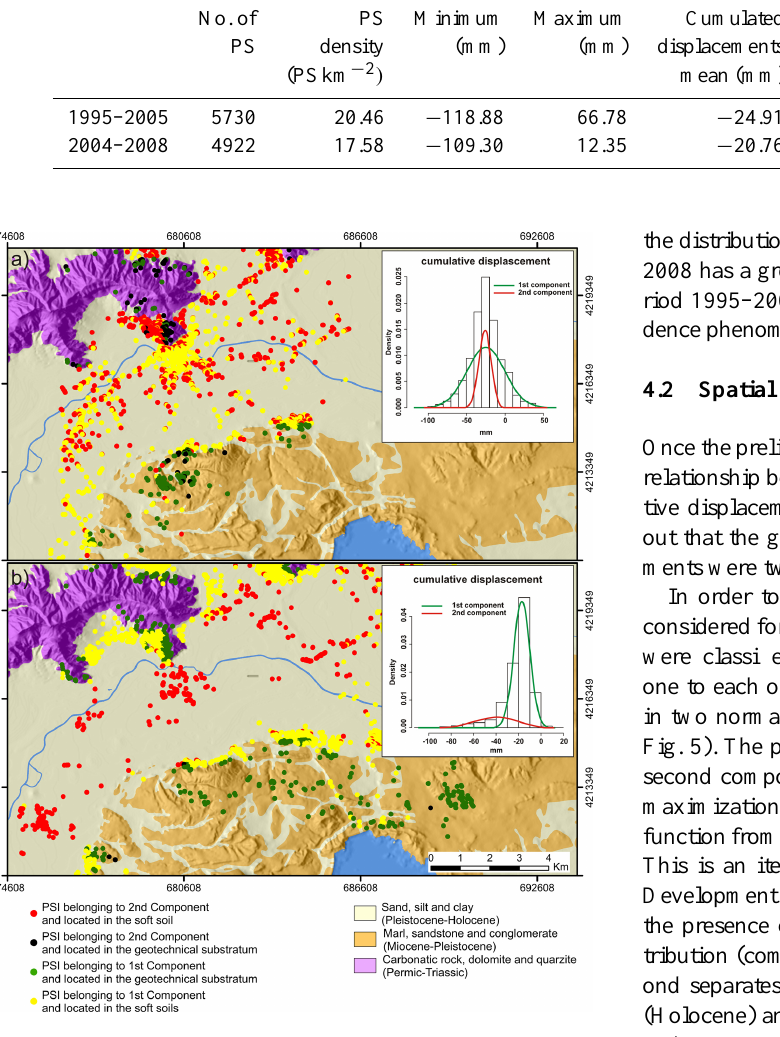
Figure 5. PS classification according to normal distributions (first and second components) and geological criteria for both studied pe- riods: (a) 1995–2005 and (a)